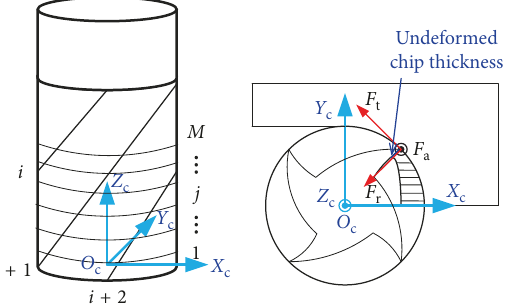
Figure 1: Discretization of cutter, forces imposed on one disk, and undeformed chip thickness on rake